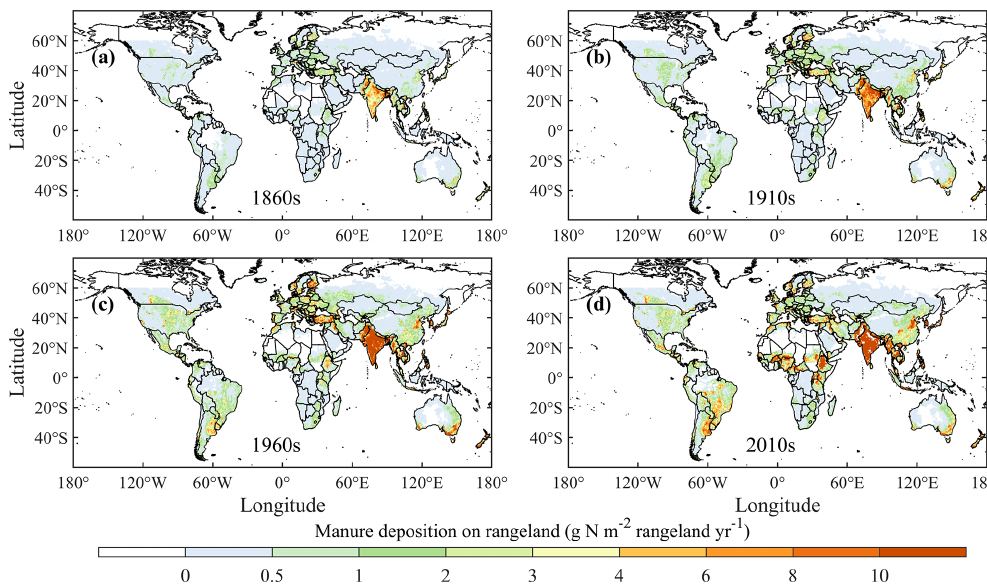
Figure 10. Spatial patterns of manure N deposition on rangeland in the 1860s, 1910s, 1960s, and 2010s.